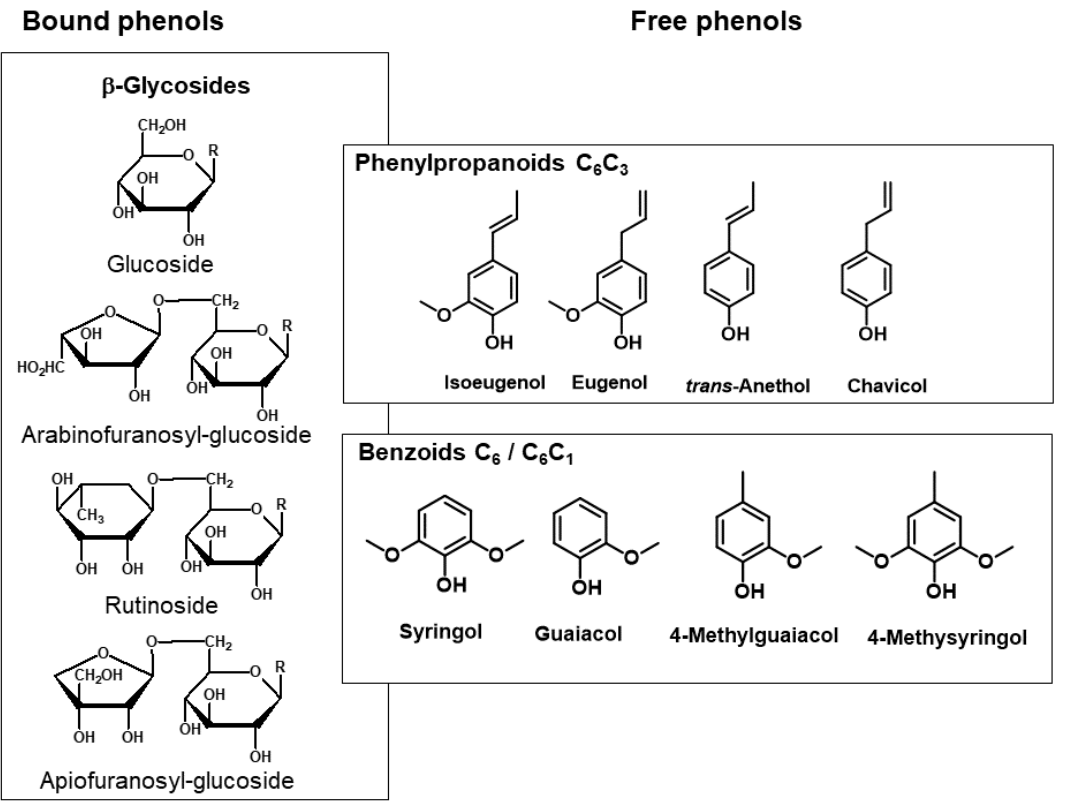
Figure 6. Structures of glycosidically bound volatile phenols.